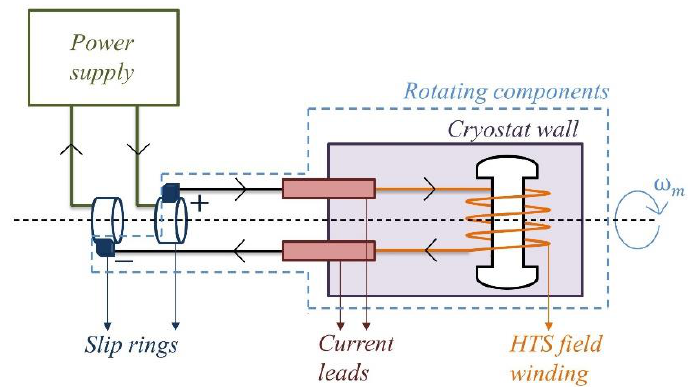
Figure 1. Supply system of the rotor HTS field winding of the EcoSwing turbine [41].